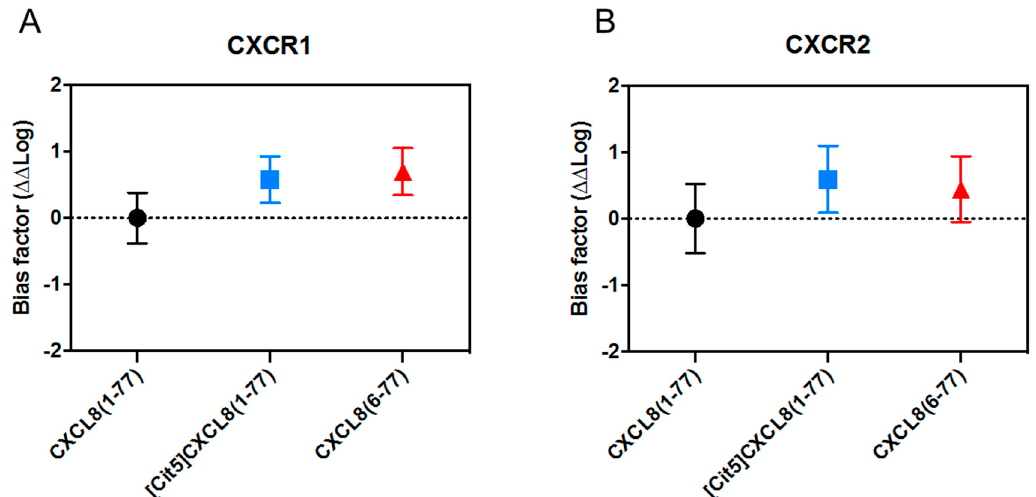
Figure 6. CXCL8(1-77), [Cit 5 ]CXCL8(1-77) and CXCL8(6-77) are no biased ligands for CXCR1 and CXCR2. Bias plot of CXCR1 ( A ) and CXCR2 ( B ), represented as ΔΔ Log for G α i signaling (cAMP reduction) against β -arrestin 2 recruitment of the different CXCL8 variants compared to natural CXCL8(1-77) ± SEM [63].